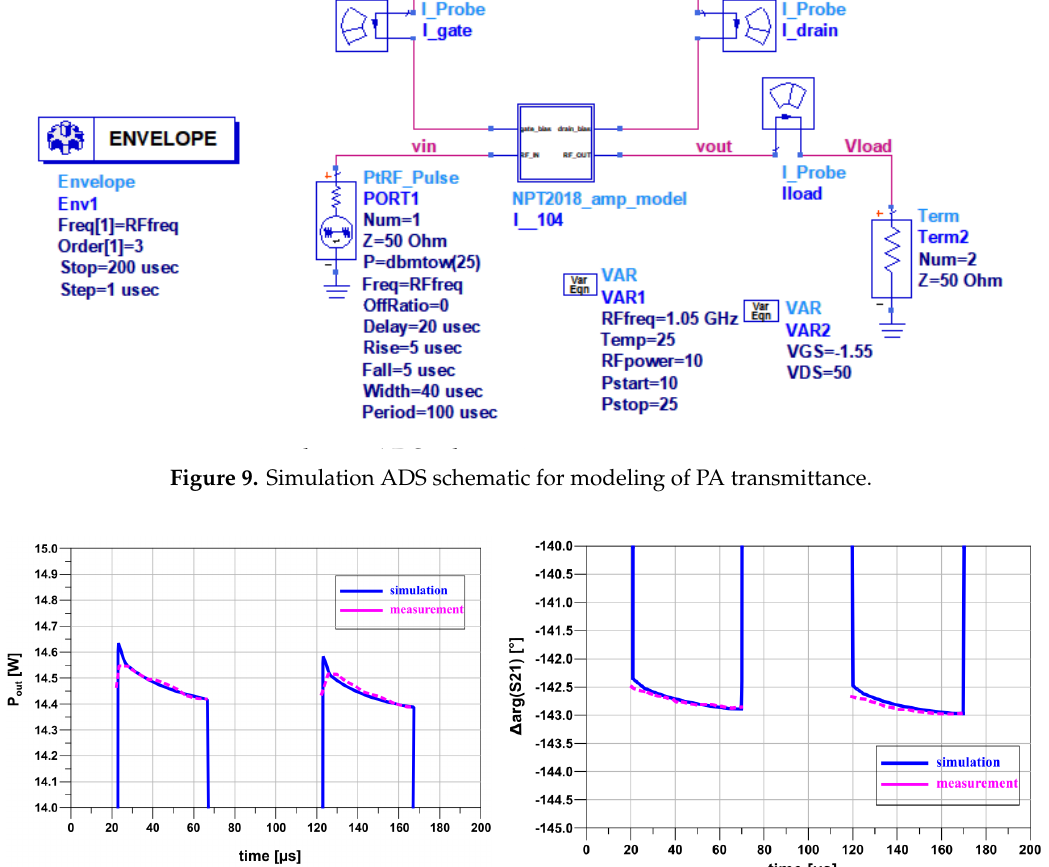
Figure 9. S imulation ADS schematic for modeling of PA transmittance.